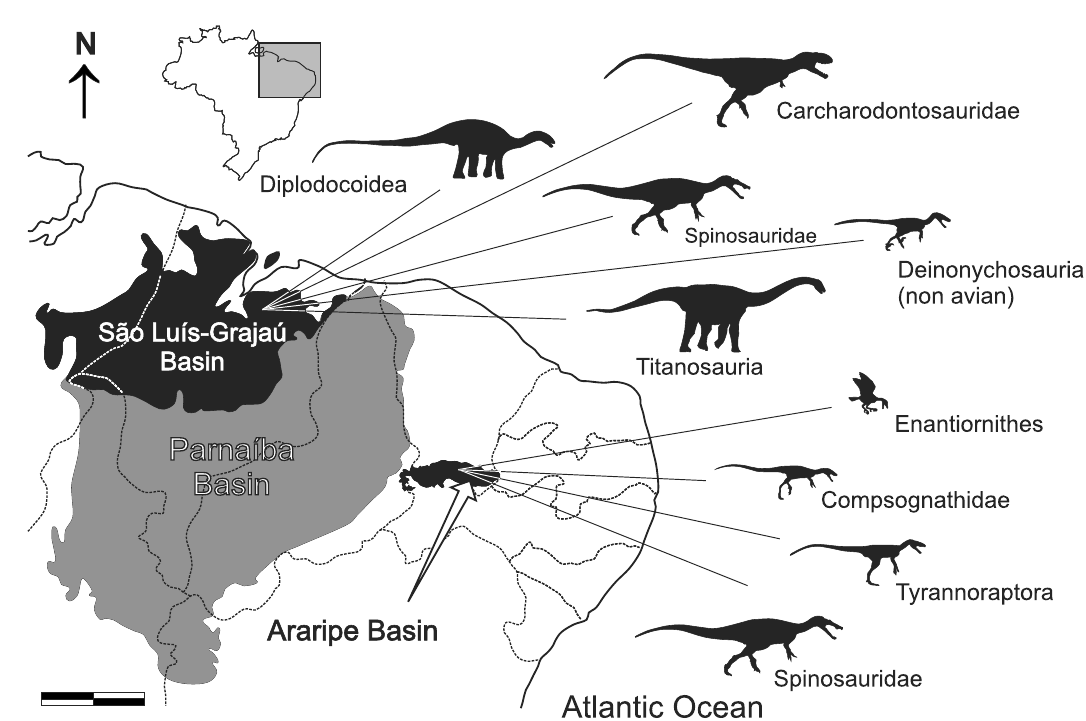
Fig. 3 – Map of northeastern Brazil depicting the Parnaíba Basin (grey), and São Luís-Grajaú and Araripe basins (black). The dinosaur record follows Tables I-II. Modified from Martill (1993), Rossetti (2001) and Santos and Carvalho (2004). Scale = 200